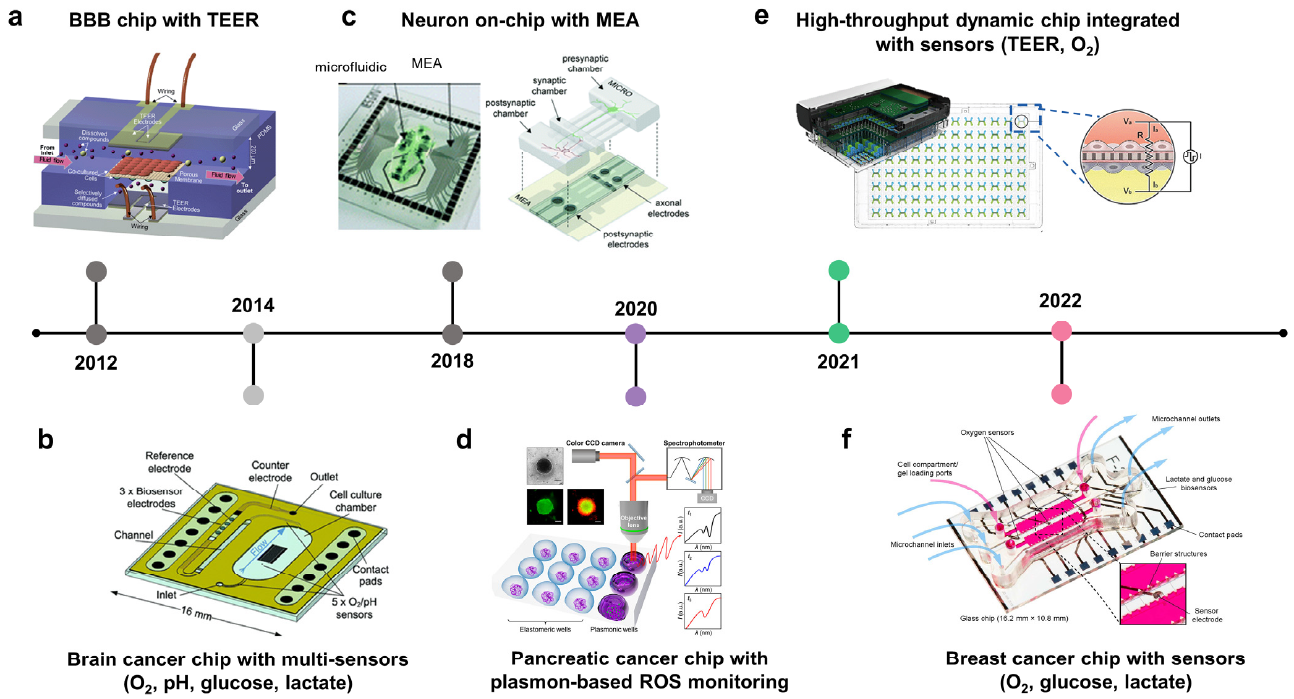
Figure 4. Repurposable integrated sensors on microphysiological analysis platforms (MAP) to moni- tor real-time physiological responses and signaling pathways. A timeline showing the development of microfluidic chips with integrated sensors for cancer modeling and drug development. ( a ) Blood– brain barrier (BBB) with transepithelial/transendothelial electrical resistance (TEER) (adapted with permission from Ref. [132]. Copyright 2012, Royal Society of Chemistry). ( b ) Cancer chip with multi-sensors (O 2 , pH, glucose, and lactate). Integrated biosensors to brain cancer on-chip or MAP for monitoring changes of pH, oxygen, glucose, and lactate induced by tumor metabolism (adapted with permission from Ref. [134]. Copyright 2014, Royal Society of Chemistry). ( c ) Neuron on-chip with multi-electrode array (MEA) (adapted with permission from Ref. [136]. Copyright 2018, Royal Society of Chemistry). ( d ) Pancreatic cancer chip with plasmon-based monitoring of reactive oxygen species (adapted with permission from Ref. [137]. Copyright 2020, American Society Chemistry). ( e ) High throughput breast cancer chip integrated with cancers (adapted with permission from Ref. [133]. Copyright 2021, CC BY-NC 3.0). ( f ) Breast cancer chip with sensors (O 2 , glucose, and lactate) (adapted with permission from Ref. [135]. Copyright 2022, CC BY 3.0) .